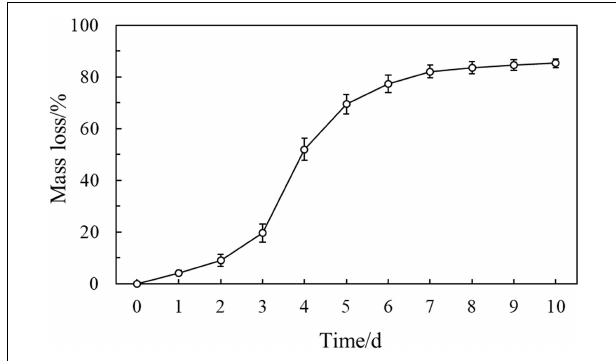
FIGURE 5 | Mass loss of the filter paper decomposed by the NMCel-crop1 fungus.